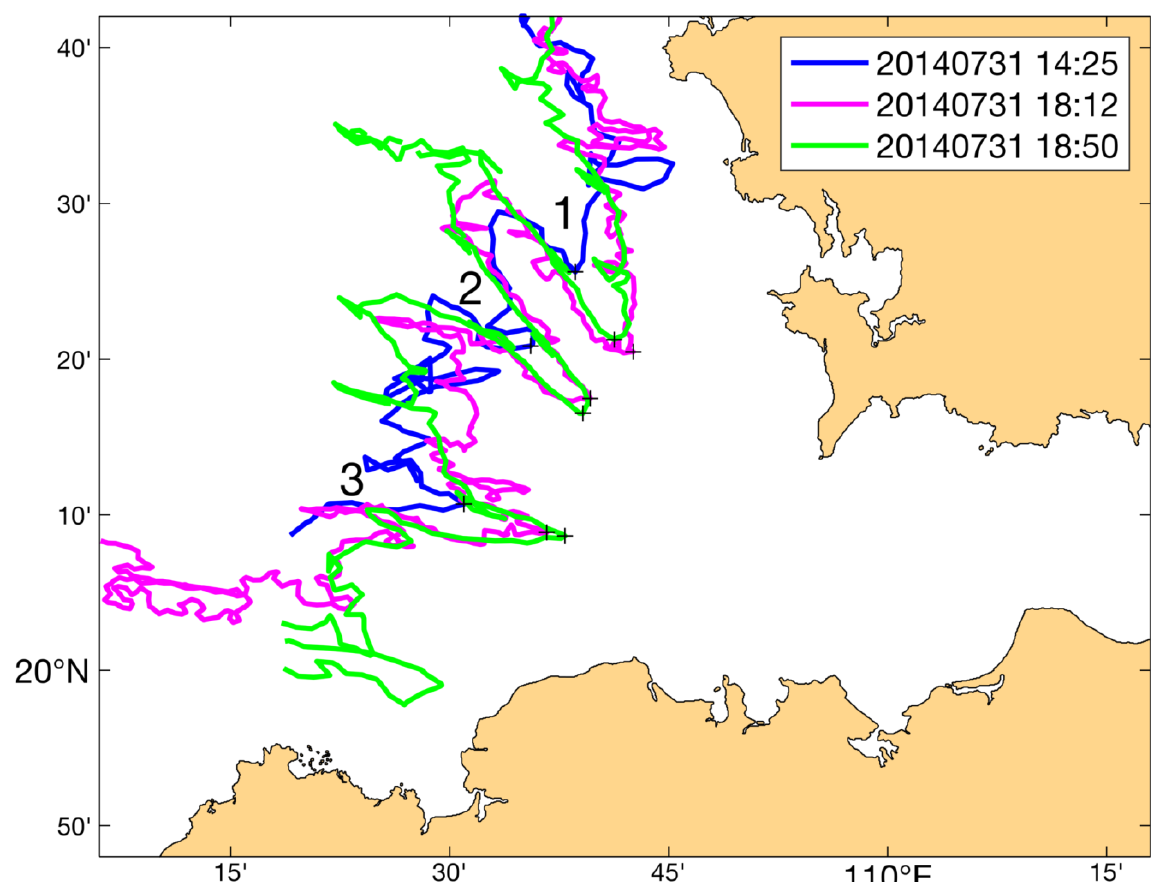
Figure 9. The peripheries (31.2 °C isotherm) of warm water tongue observed by MODIS-T (blue contours), VIIRS (purple contours), and MODIS-A (green contours) on 31 July 14:25, 18:12, and 18:50, 2014.